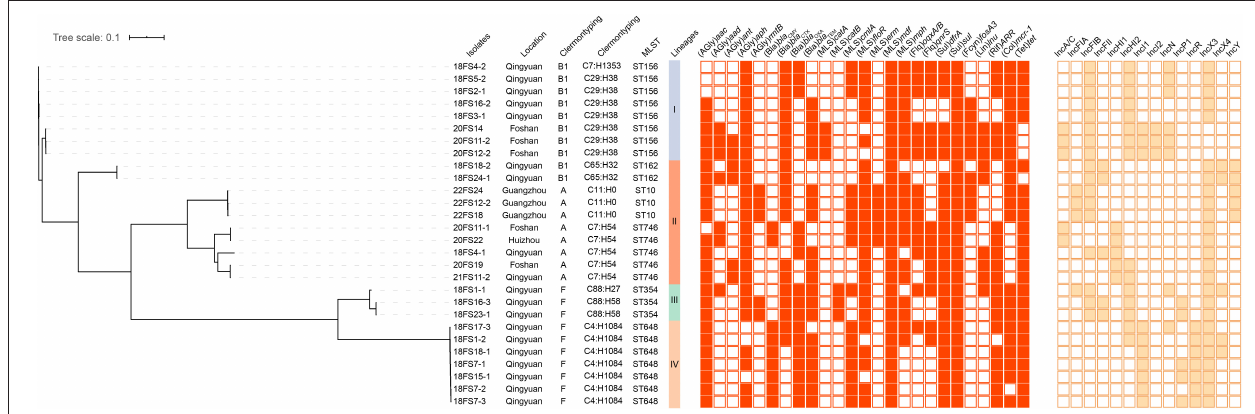
FIGURE 2 | Analysis of bla NDM -positive E. coli isolates from ducks in Guangdong, China. Relationships among 28 bla NDM -positive E. coli isolates are indicated using a maximum likelihood tree. Red-filled squares indicate possession of the indicated antimicrobial resistance genes (ARGs) and brown-filled squares indicated plasmid Inc